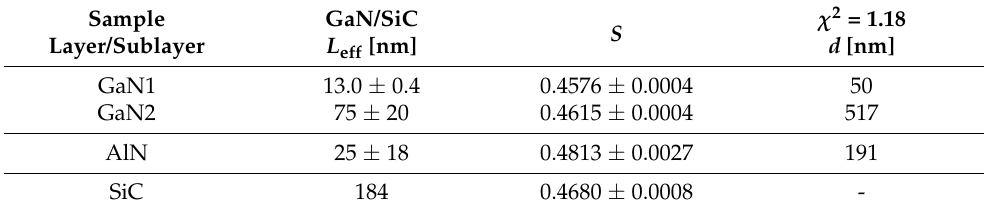
Table 1. Best fit parameters obtained via VEPFIT software using the S ( E + ) and F Ps ( E + ) depth profiles. Values without any error margins represent fixed parameters.